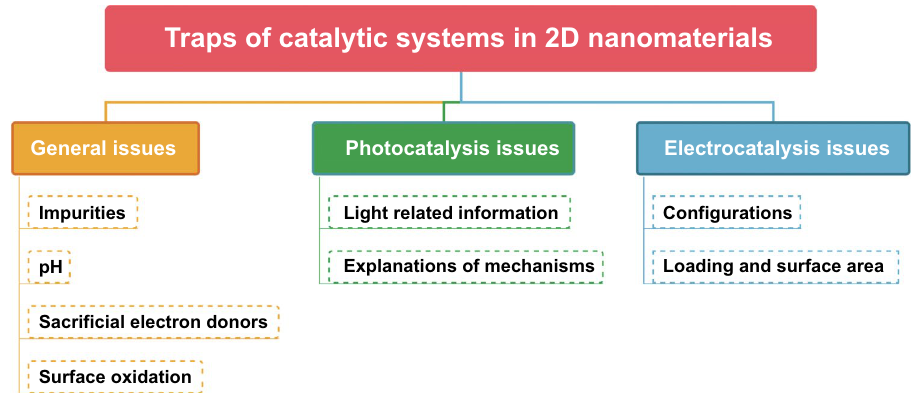
Fig. 3 A brief summary for general and special traps of different catalysis systems in 2D nanomaterials. General issues include impurities, pH, sacrificial electron donors and surface oxidation. Specific photocatalysis issues include light-related information and explanations of mecha- nisms. Specific electrocatalysis issues include configurations and loading and surface